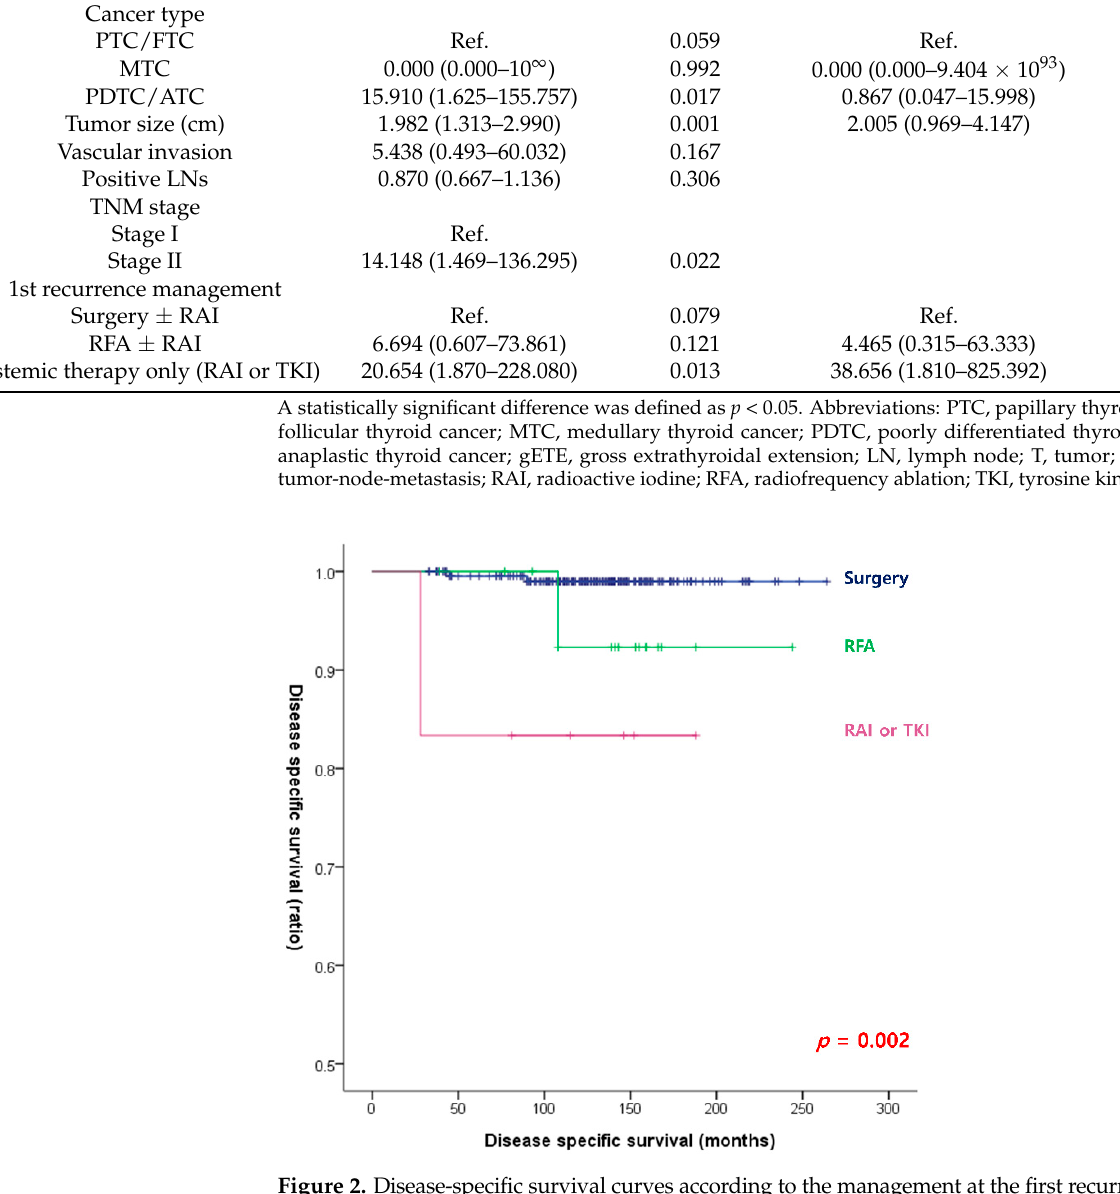
Figure 2. Disease-specific survival curves according to the management at the first recurrence (log-rank p = 0.002).